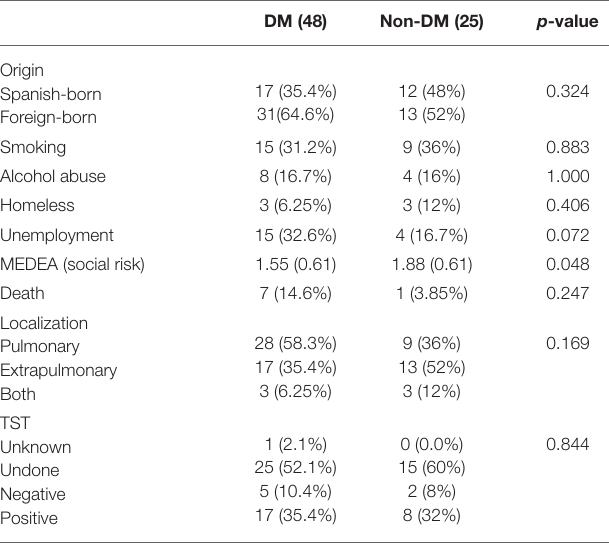
TABLE 4 | Demographic and clinical differences in TB patients according to their DM